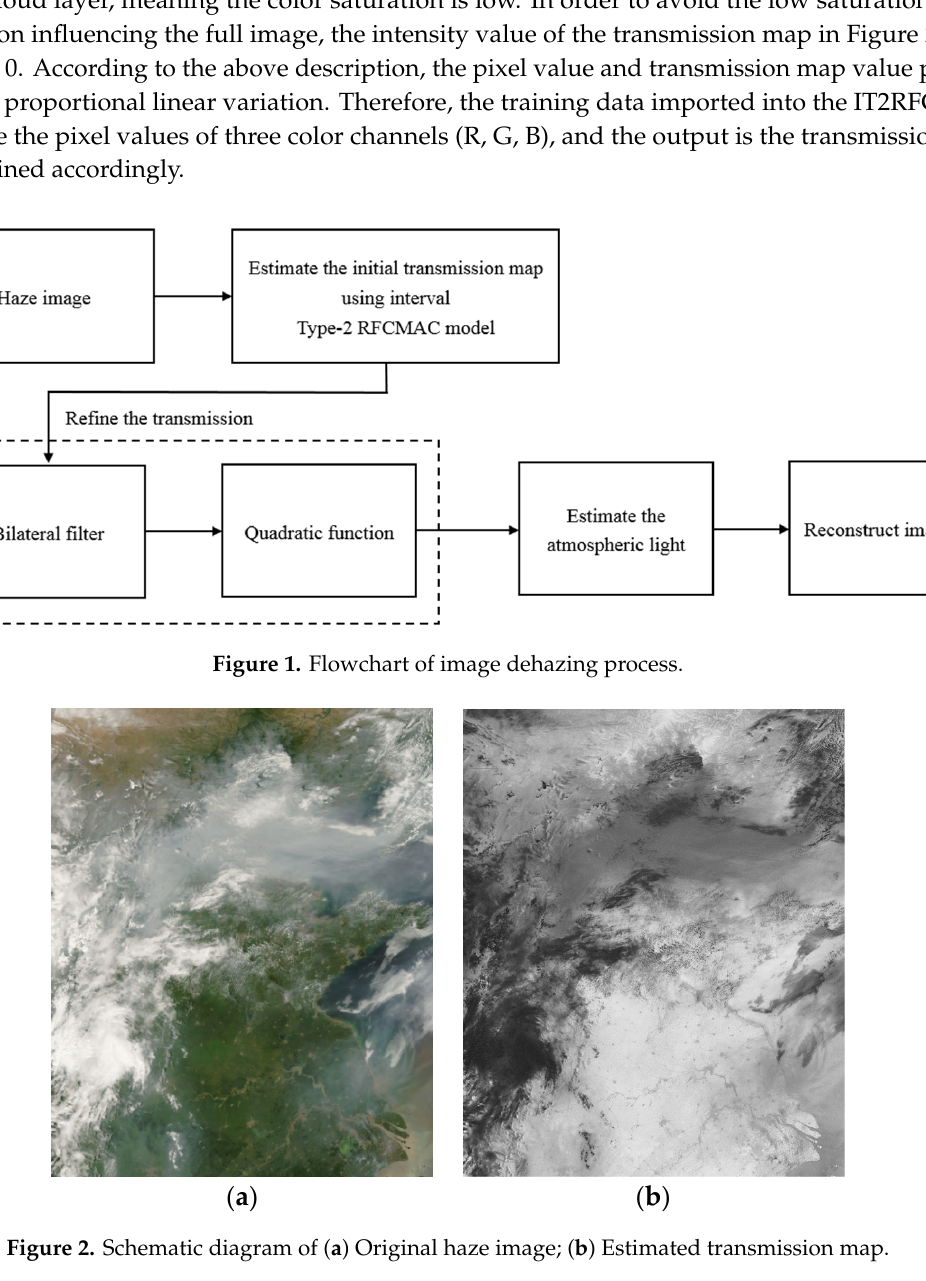
Figure 1. Flowchart of image dehazing process.